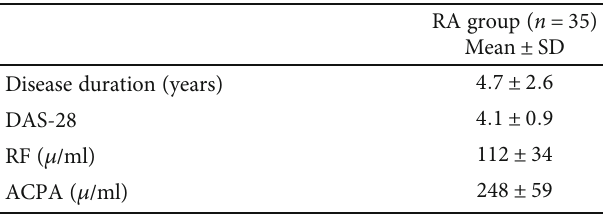
Table 2: Disease parameters of the rheumatoid arthritis